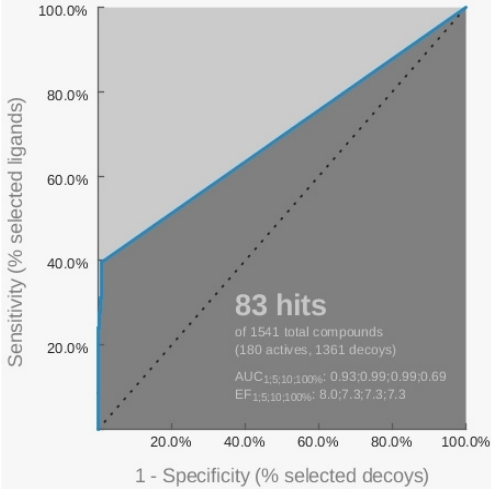
Figure 2. Representation of the ROC curve related to the pharmacophore H_2 generated starting from the 3CE5 PDB model by LigandScout